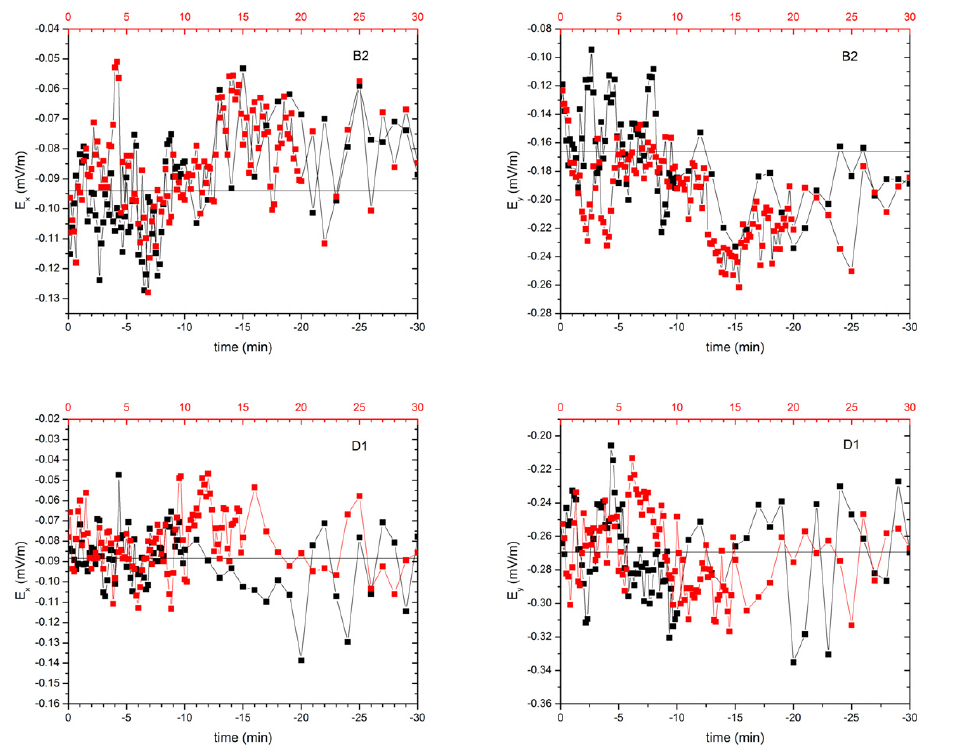
and E (in mV/m), observed along the AB and AC dipoles, respectively, related to the shots Figure 8. Natural electric field components, E x y in B2 and D1. Black symbols are used for data measured 30 min before the shot, while red symbols are used for data registered after the shot. The zero time of both the black and red scales corresponds to the shot time. The black continuous line represents the average value of the field component before the